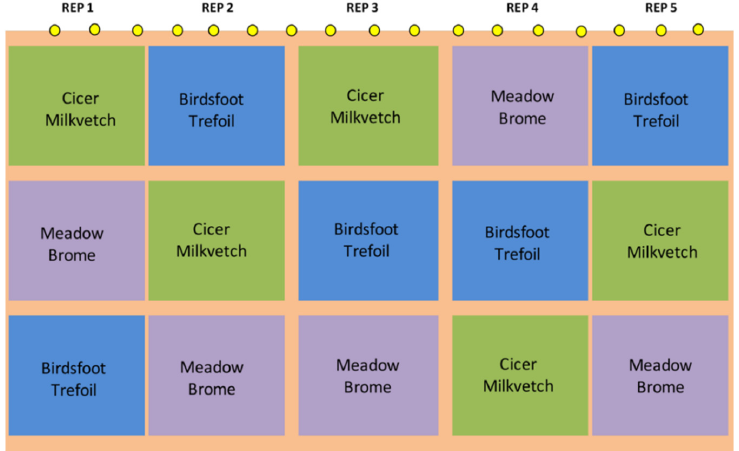
Figure 1. Plot plan of the grazing study. Cattle were assigned to one of fifteen plots between 2014 and 2018 and rotationally grazed for 7 to 12 weeks depending on the year. Yellow circles indicate irrigation risers.